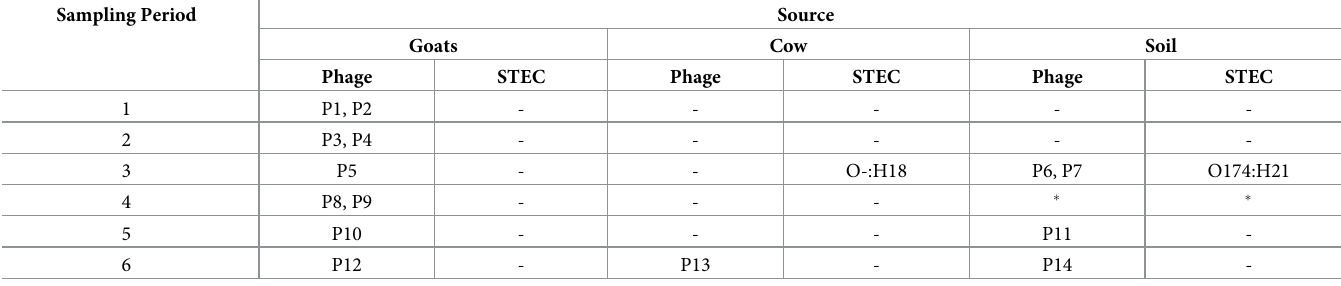
- indicates no STEC strain was isolated. � indicates source was not sampled.